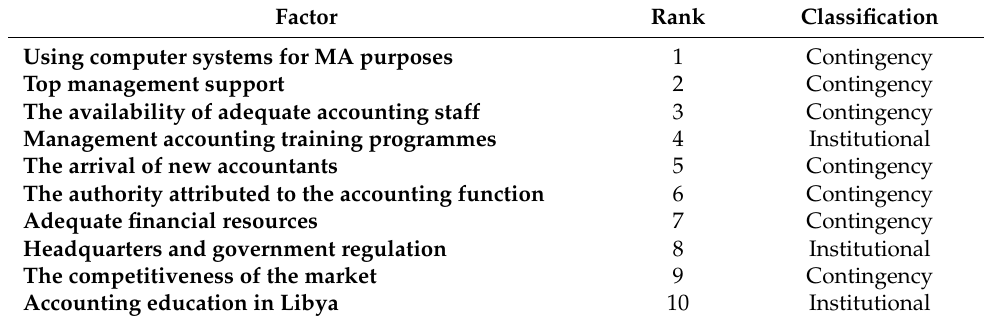
Table 17. The top ten factors that may facilitate the adoption of MAIs in the non-manufacturing sector. Factor